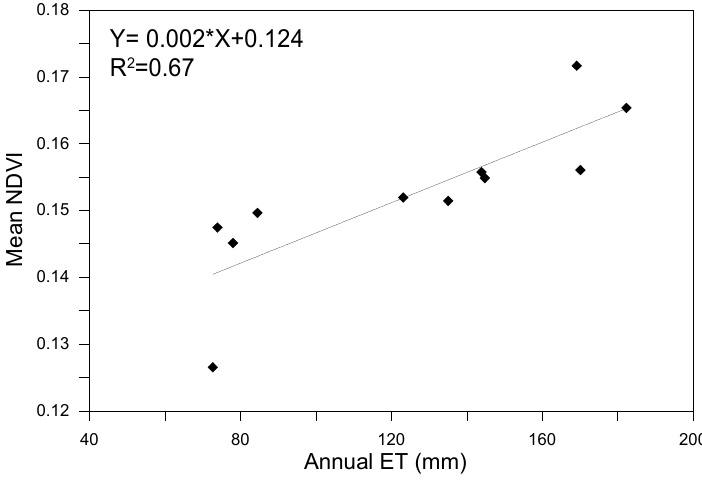
and mean NDVI from 2001 to 2011. a